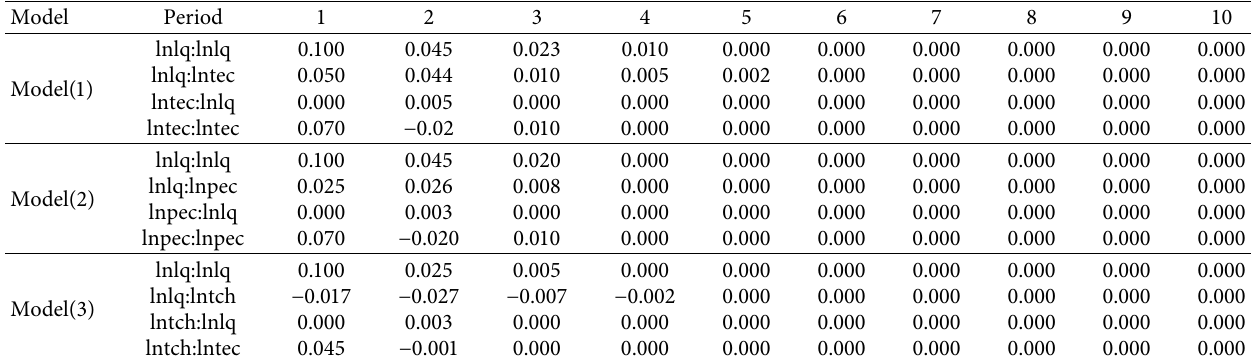
Table 6: Impulse response function results.